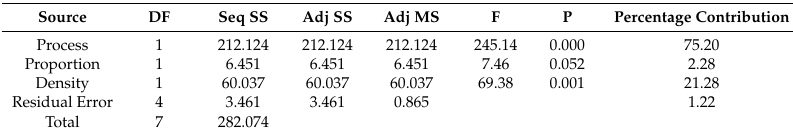
Table 8. ANOVA for SN ratios of thermal conductivity.